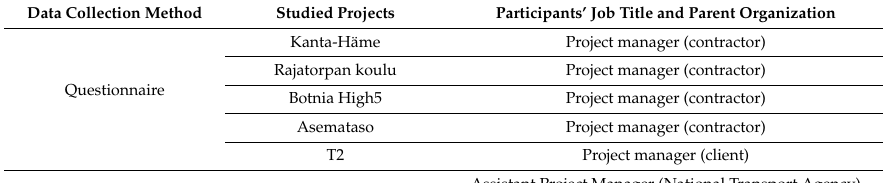
Table 4. The job profiles of interviewees and survey